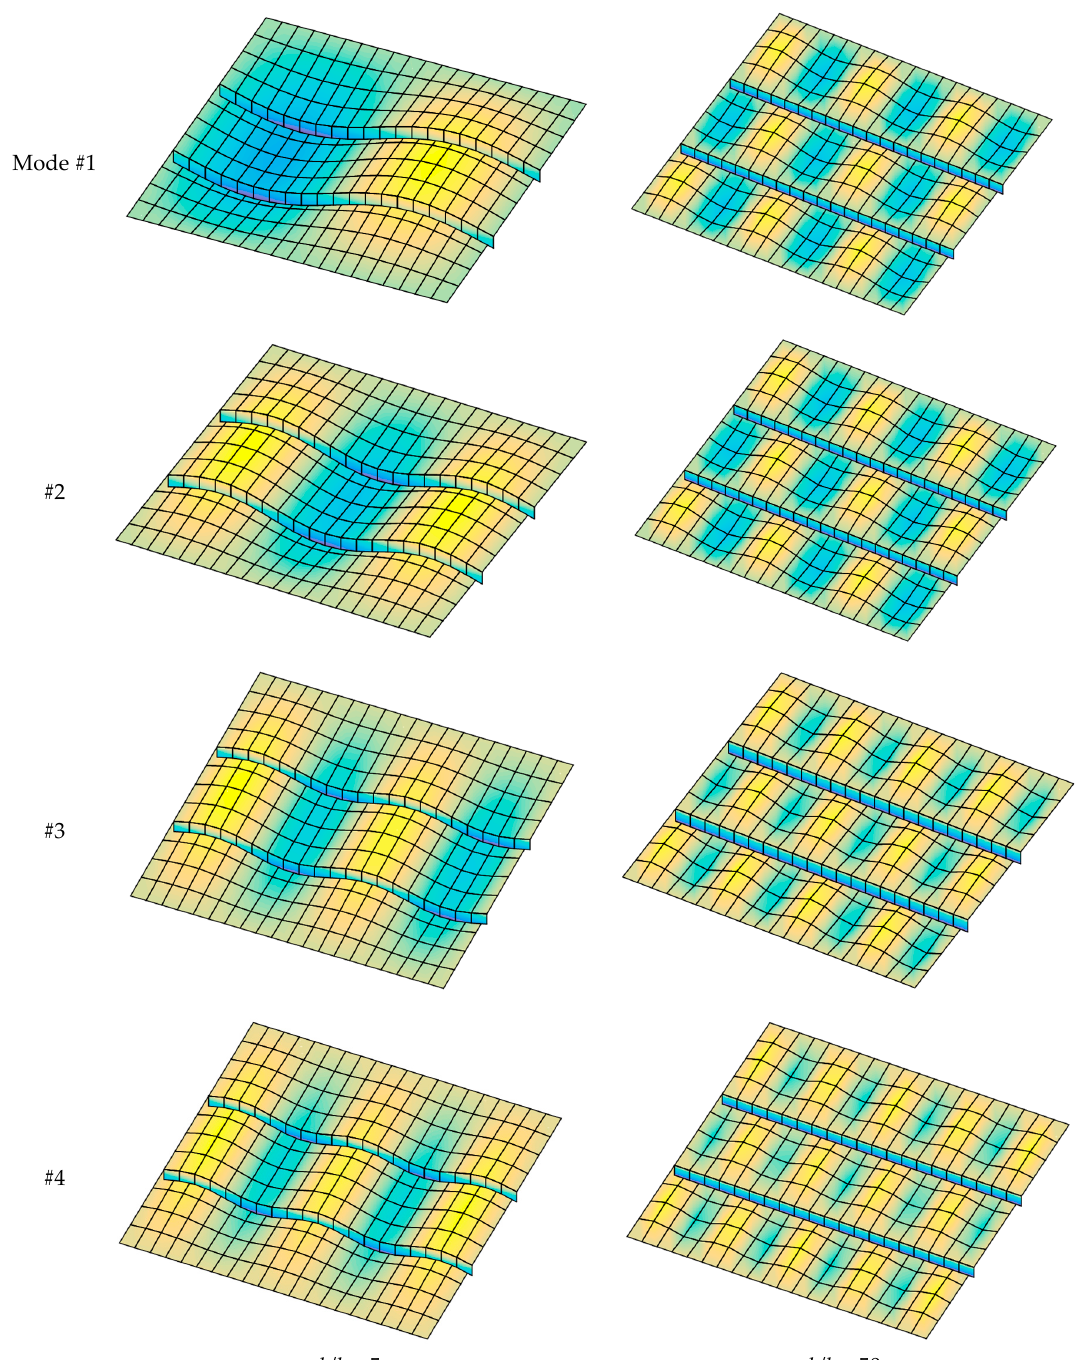
Figure 16. The first four buckling mode shapes of FGM plate with two stiffeners ( n = 0.5, Si 3 N 4